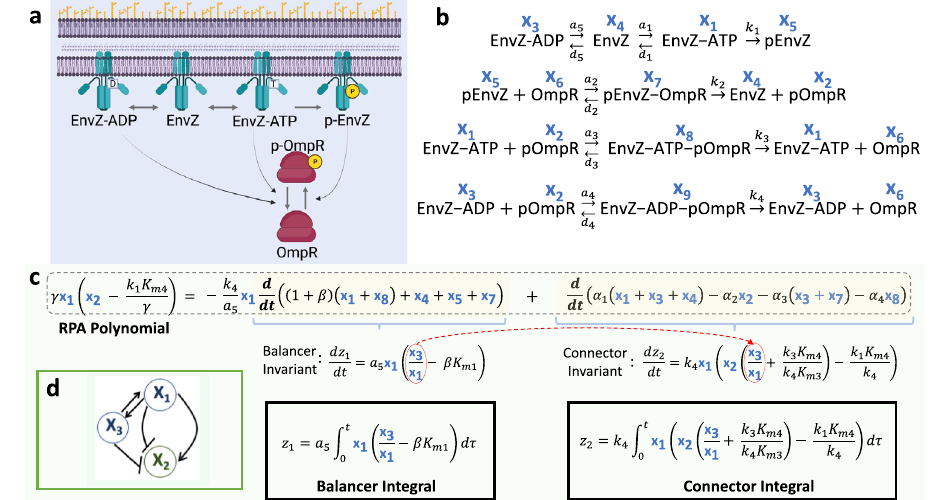
Fig. 3 | The EnvZ-OmpRbacterialtwo-componentsystem employing both ATP and ADP as cofactors, as originally proposed by Shinar and Feinberg 2 . a Schematic of the EnvZ-OmpR phosphorelay system. Created with BioR- ender.com. b The corresponding CRN. c The CRN implements integral control via the computation of two independent polynomial invariants – a Balancer invariant, andaConnectorinvariant – eachobtainedbyalinearcoordinatechange.Theseare